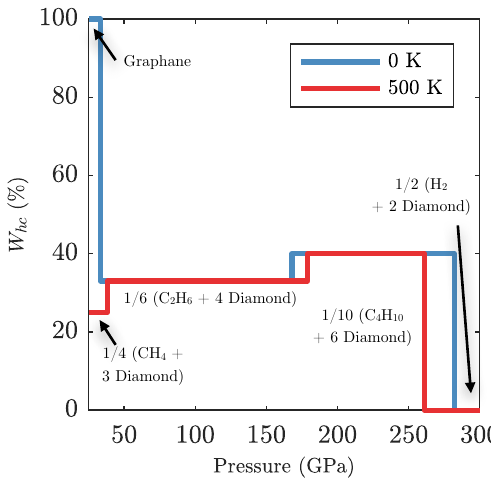
Figure A5. The amount of carbon locked into hydrocarbons and therefore unable to form diamond, W hc as a function of pressure, for a graphane/polystyrene